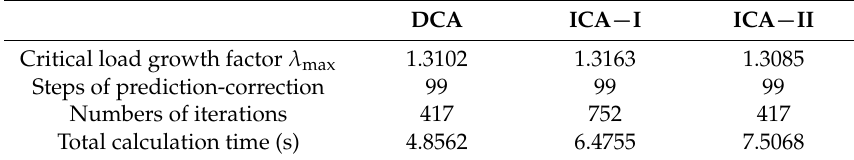
Table 5. Comparisons of proposed decoupling CPF algorithm and integrated algorithms under